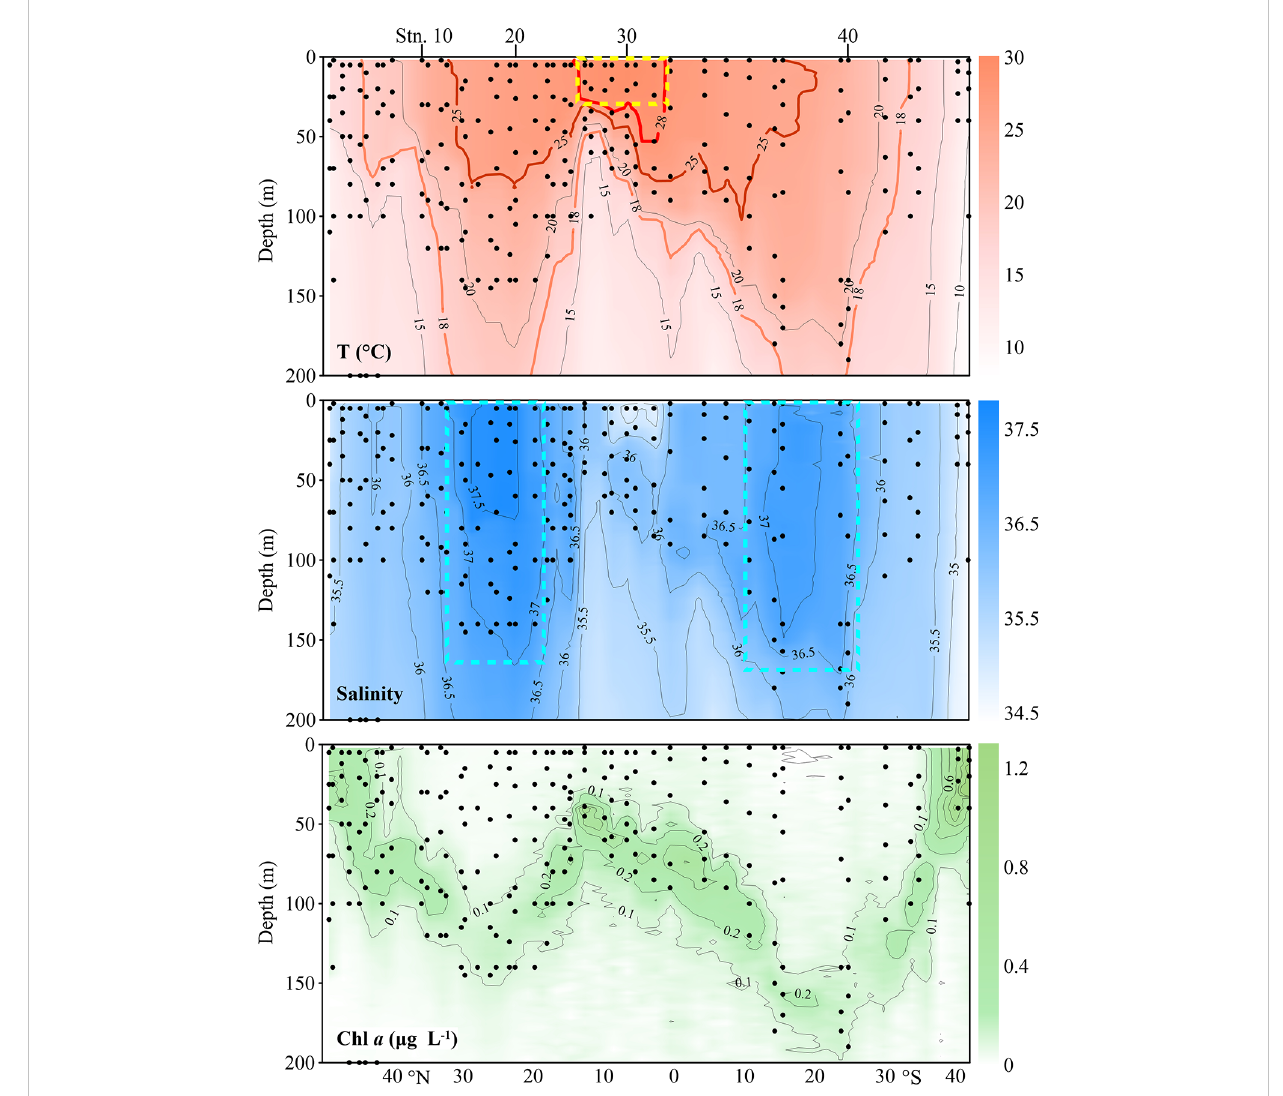
FIGURE 2 Distribution of temperature (T), salinity and in vivo chlorophyll fl uorescence (Chl a ) along the AMT transect. Each dot represents one sampling point. The yellow box indicates the Equatorial Zone centre. The cyan boxes delimit gyre centres. Black dots denote the locations of sample